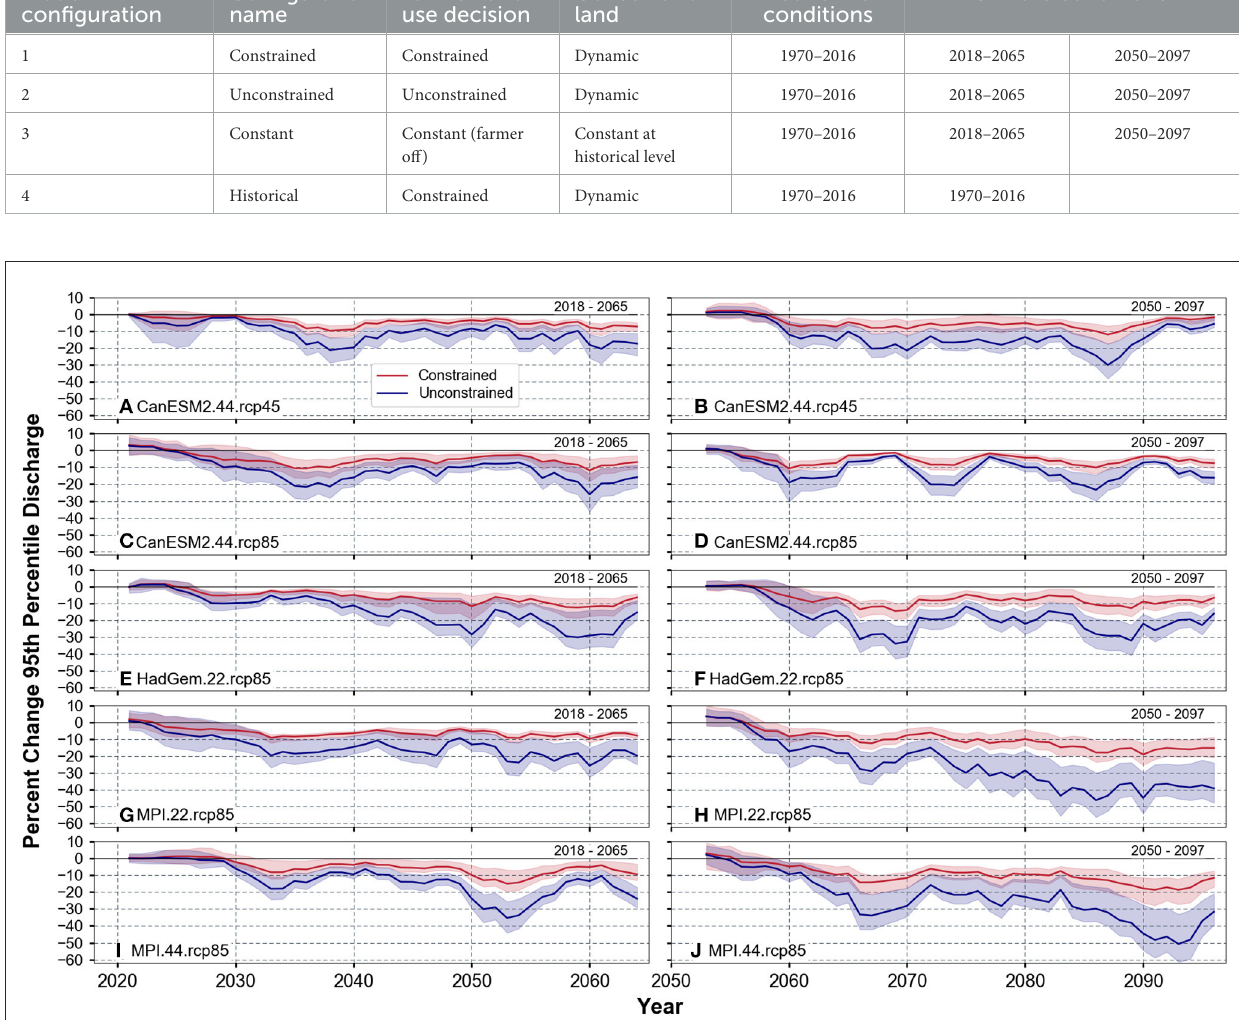
FIGURE4 Means (solid lines) and ranges (shaded areas) of percent change in 95th percentile discharge for the constrained (red) and unconstrained (blue) scenarios relative to the constant scenario for 2018–2065 (A, C, E, G, I) and 2050–2097 (B, D, F, H, J) .